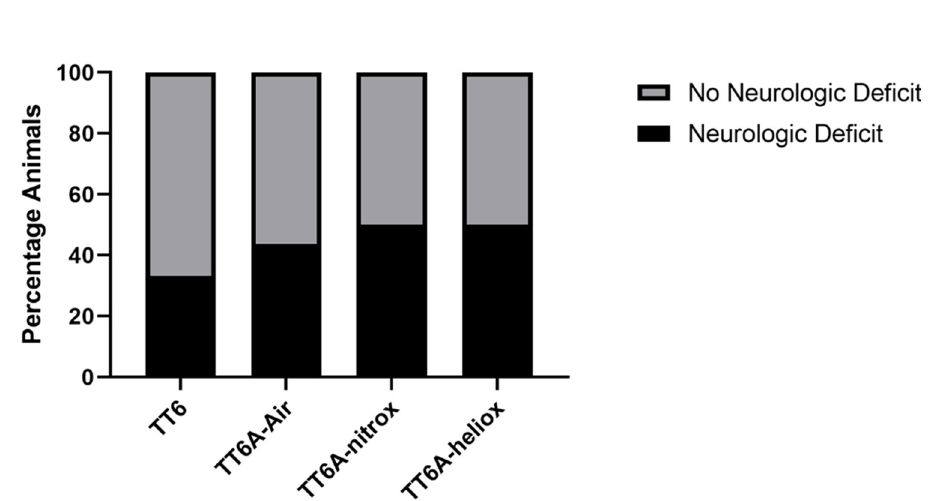
Fig 7. Shows spinal cord sectioning and representative pathologic samples for each spinal cord region and treatment table.